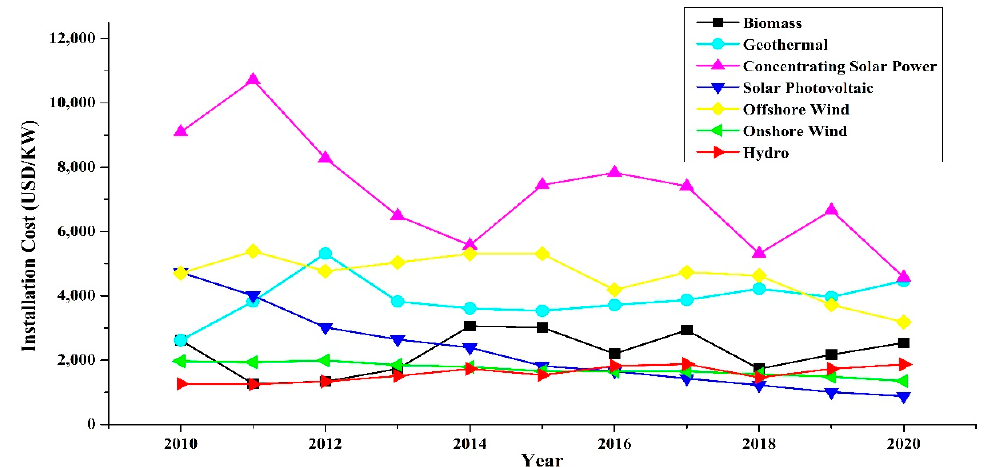
Figure 7 . Installation Cost of various renewable energy [75]. Figure 7. Installation Cost of various renewable energy